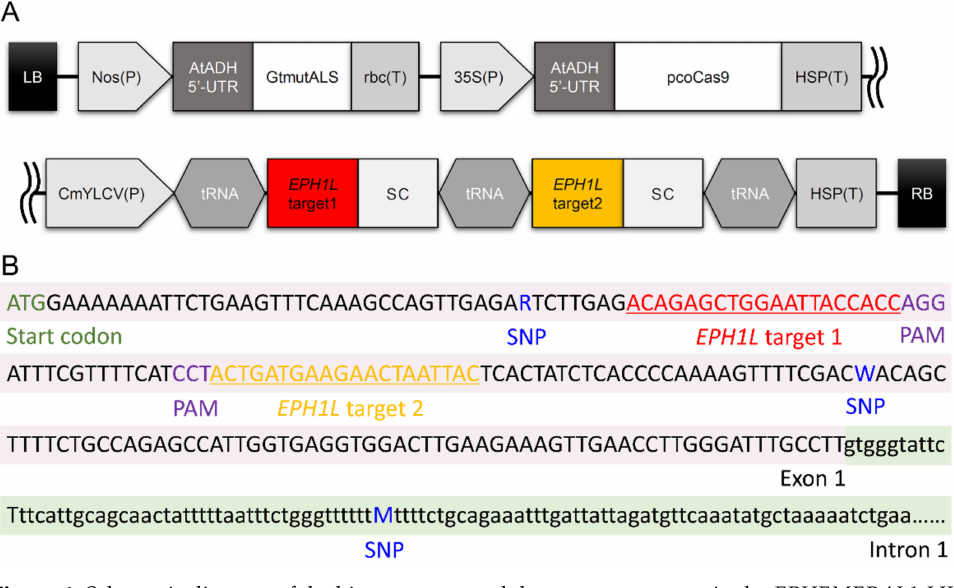
Figure 4. Schematic diagram of the binary vector and the target sequences in the EPHEMERAL1-LIKE in Japanese gentians. ( A ) The diagram of the pSALS-35SpCas9-CmYLCVpEPH1Lt1t2. LB, left border of T-DNA; Nos(P), promoter of the nopaline synthase gene of Agrobacterium tumefaciens ; AtADH 5 (cid:48) -UTR, 5 (cid:48) —untranslated region of the alcohol dehydrogenase gene of Arabidopsis thaliana ; GtmutALS, mutant acetolactate synthase gene of Gentiana triflora ; rbc(T), terminator of small subunit 2B of ribulose 1, 5-bisphosphate carboxylase/oxygenase of A. thaliana ; 35SP(P), Cauliflower mosaic virus 35S promoter; pcoCas9, plant codon-optimized Cas9 of Streptococcus pyogenes ; HSP(T), terminator of heat shock protein 18.2 of A. thaliana ; CmYLCV(P), Cestrum yellow leaf curling virus promoter; SC, single- guide RNA scaffold; RB, right border of T-DNA. ( B ) First exon sequence containing target sites 1 and 2 for genome editing. R, W, and M are marked by IUPAC notation. Single nucleotide polymorphism (SNP) shows different bases between EPH1La and EPH1Lb . PAM, protospacer adjacent motif. Table 1. Sequence analysis of EPH1L target sequences determined by Sanger